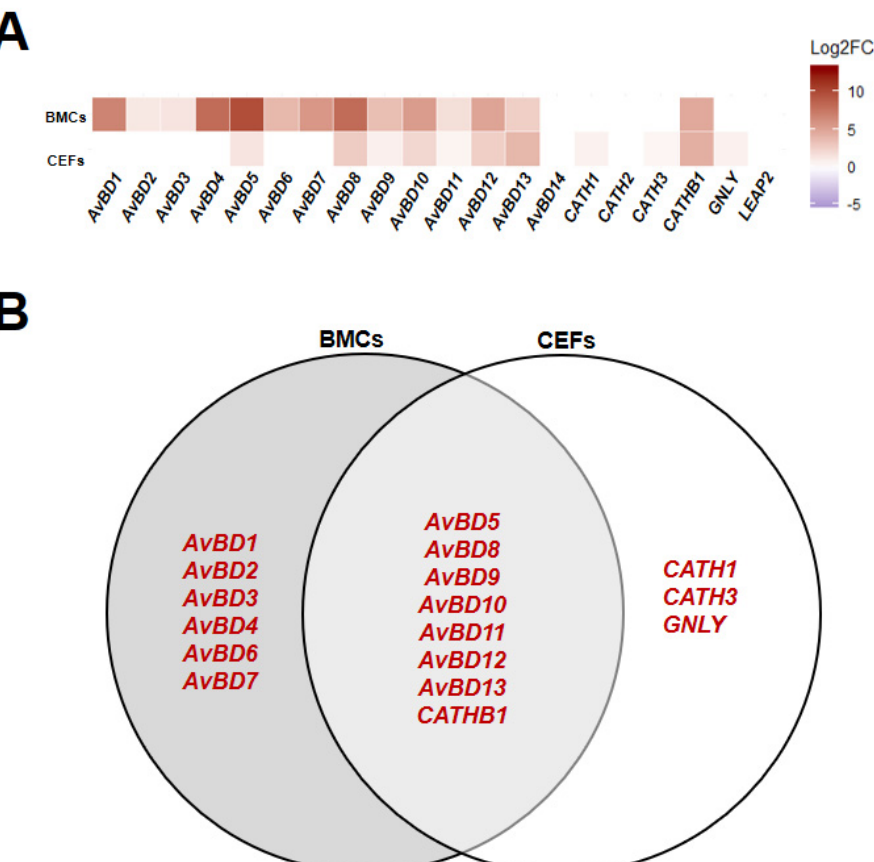
Figure 2. Expression patterns of host defense peptides (HDPs) in homeostatic state comparing Fayoumi to Leghorn within each cell type. Relative expression state (Log 2 fold change (Log2FC)) of HDPs in bone marrow-derived cells (BMCs) and chicken embryonic fibroblasts (CEFs) comparing Fayoumi to Leghorn ( A ) and Venn diagram of HDPs that were significantly differentially expressed ( p < 0.05) in BMCs and CEFs ( B ). Red font indicates higher expression in Fayoumi compared to Leghorn.